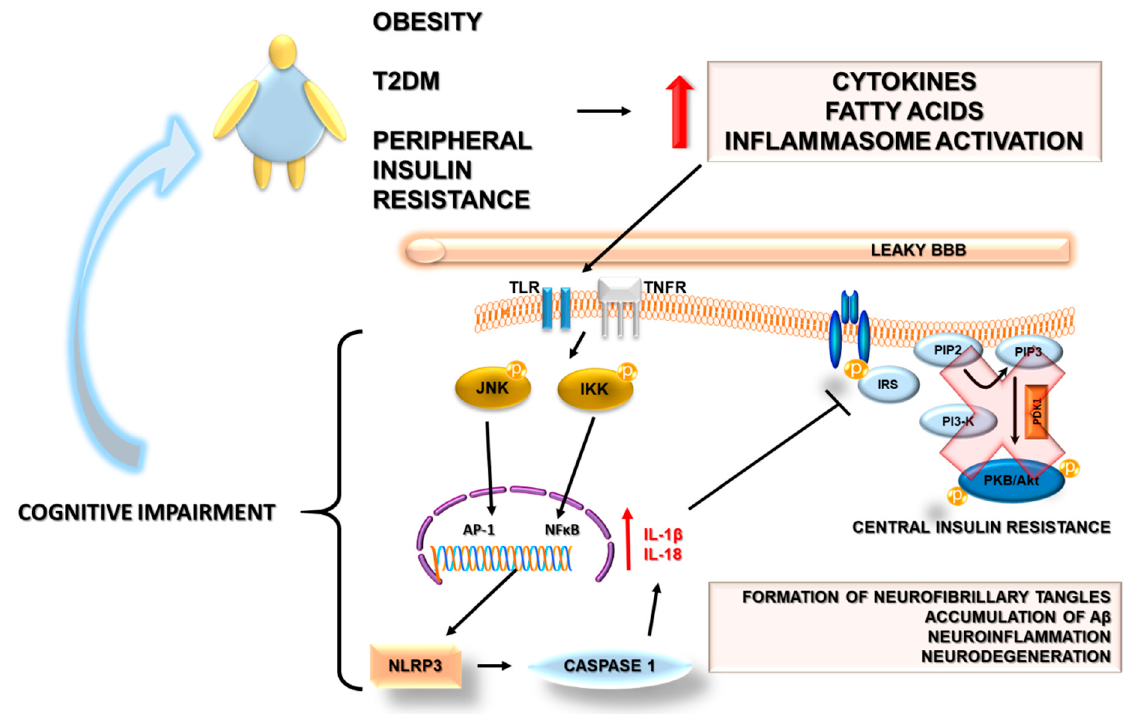
Figure 2. Potential mechanisms linking peripheral and brain insulin resistance developing during obesity, type 2 diabetes mellitus, and Alzheimer’s disease. Details in the text. The bold red arrow indicates an increase in the release of cytokines and fatty acids and an increase in inflammasome activation. The thin red arrow indicates an increase in the release of IL1 β and IL-18.